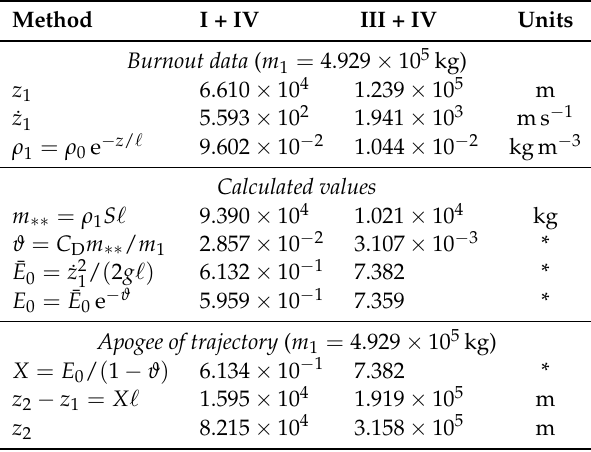
Table 4. Calculation of ballistic trajectory by method IV in Section 5.3, using initial data from methods I or II in Section